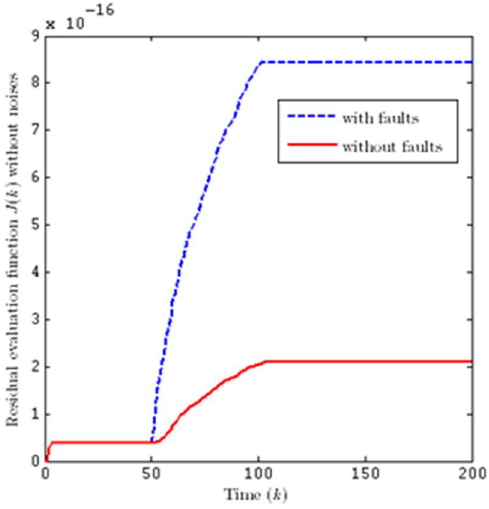
Figure 7. Residual evaluation function without noises.